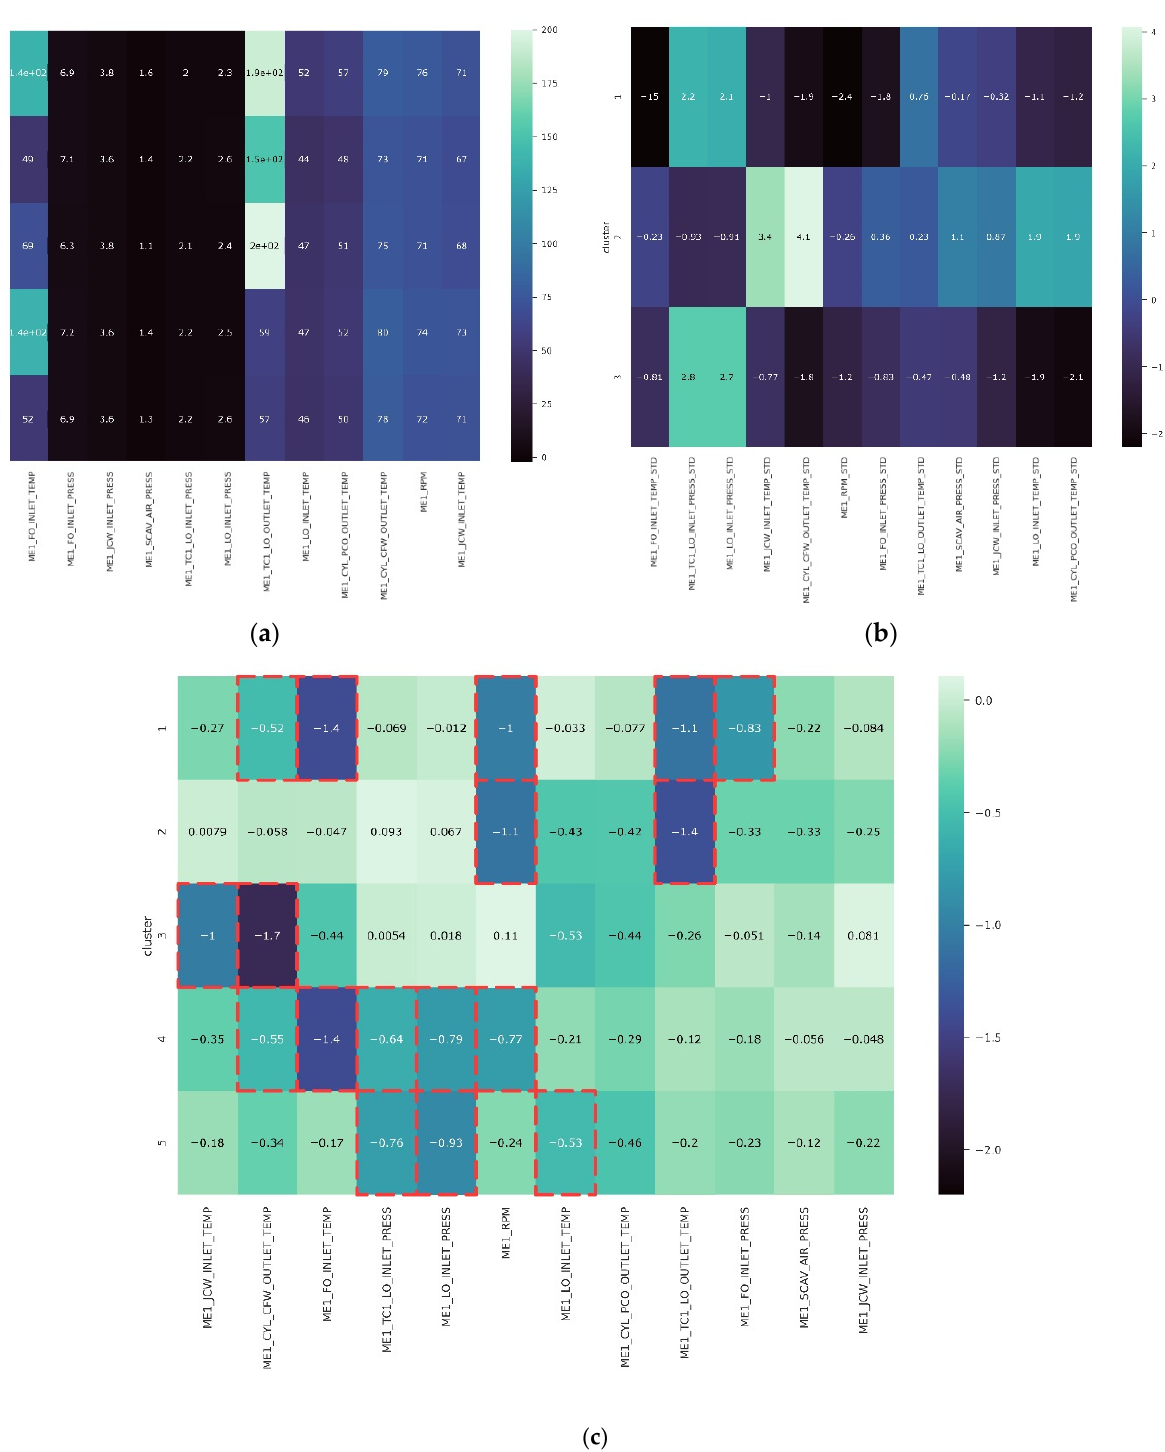
Figure 14. Heatmap comparison of ( a ) actual value, ( b ) standardized value, ( c ) SHAP value.